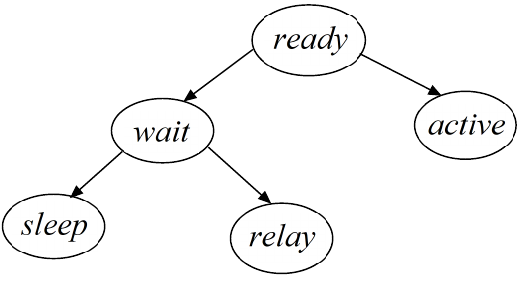
Figure 7. The state transition